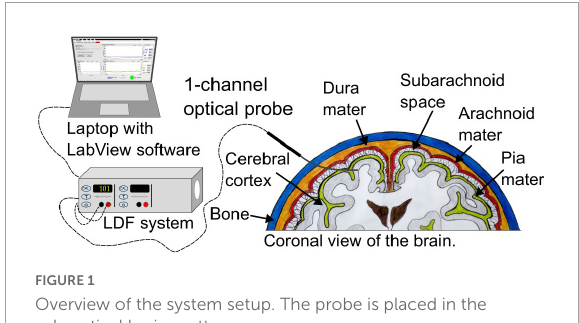
FIGURE1 Overview of the system setup. The probe is placed in the subcortical brain